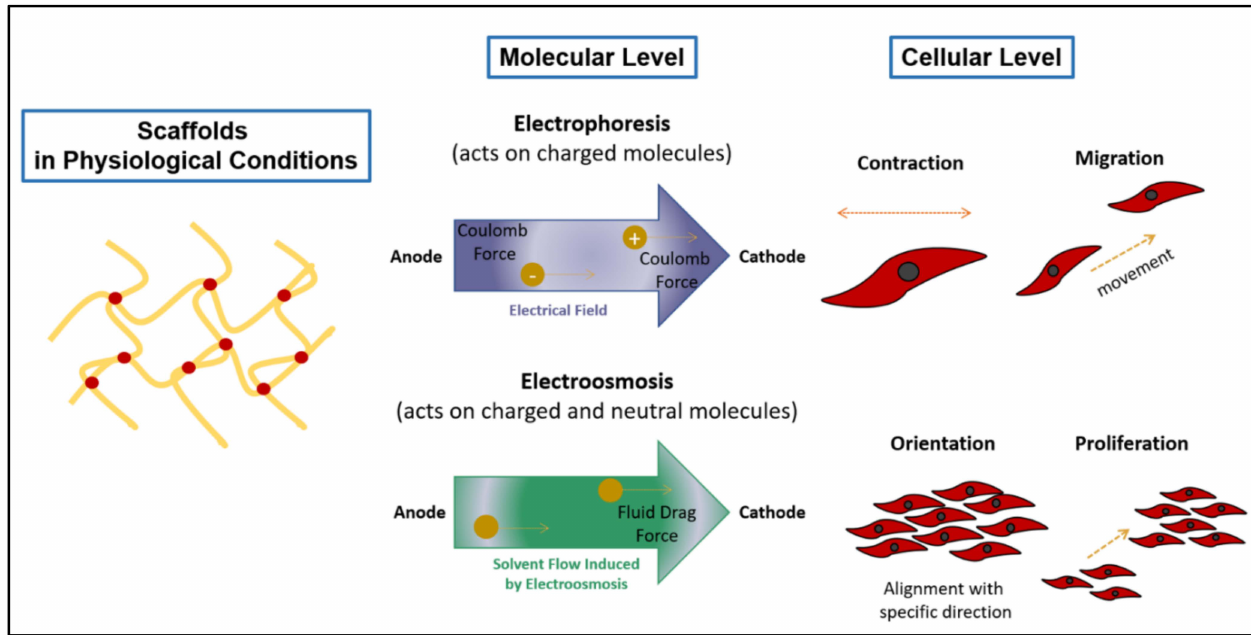
Figure 1. Illustration of the electrical conduction stimulation from conductive scaffolds, which enables cellular signalling and function in